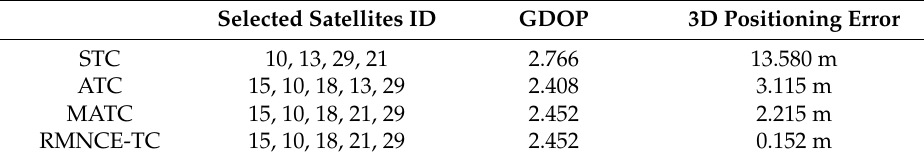
Figure 6. 3D positioning errors of the selected schemes during [730 s, 750 s]. Table 4. Satellite selection results of the different schemes at the 740-th second. Selected Satellites ID GDOP